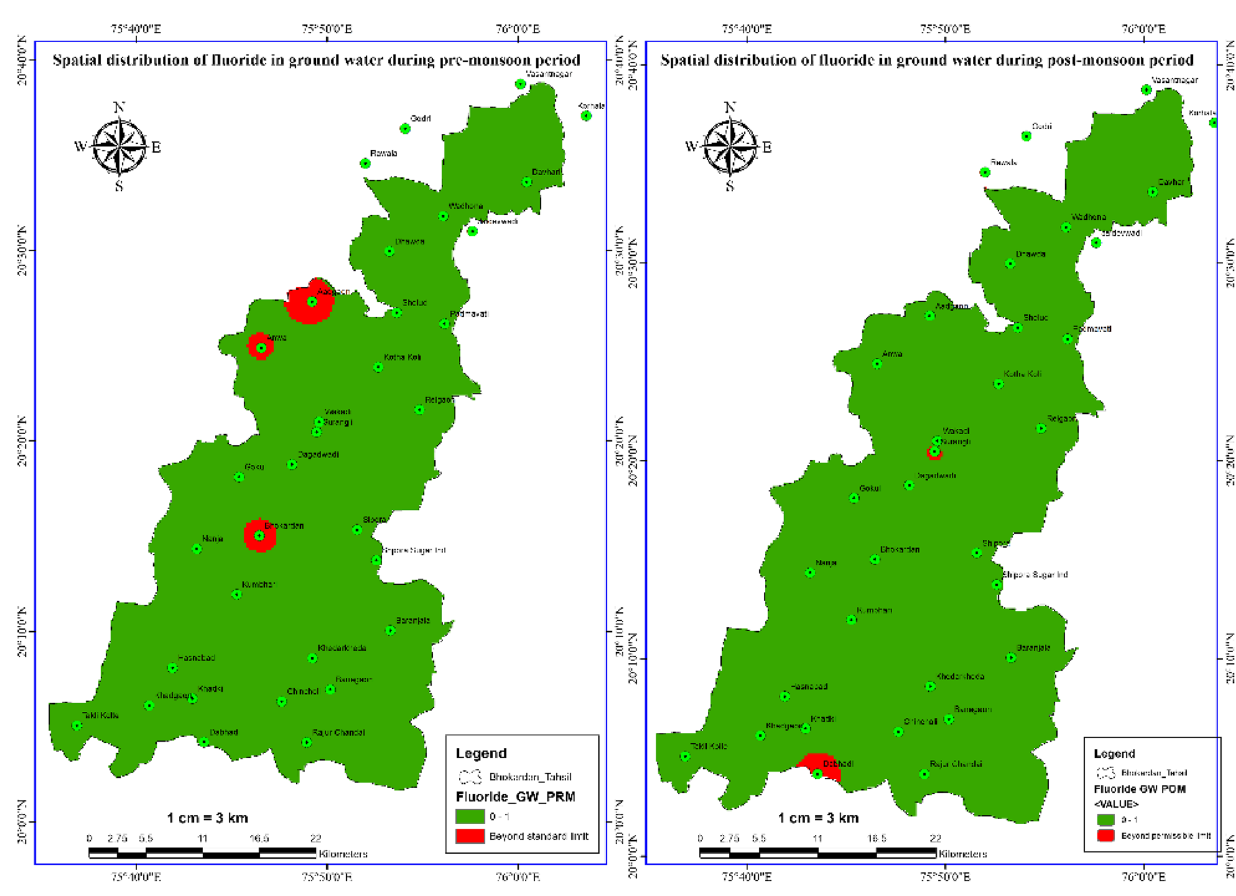
Fig. 3 Spatial distribution of fluoride in ground water during pre and post-monsoon